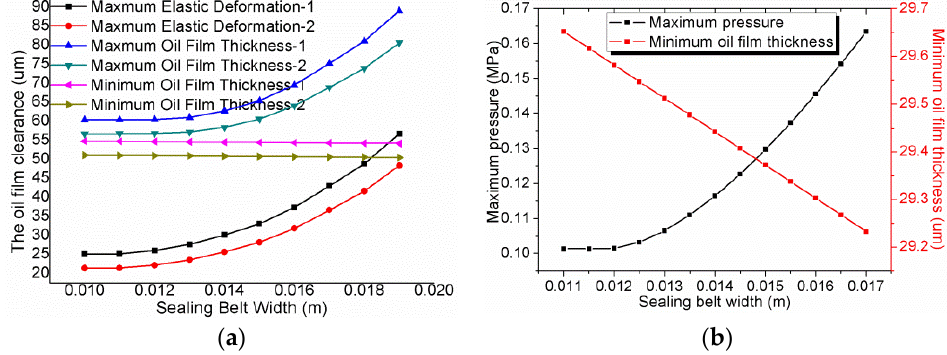
Figure 17. Effect of the sealing belt width on the oil film clearance and pressure. ( a ) the oil film thickness and the elastic deformation with the sealing belt width; ( b ) the minimum oil film thickness and maximum pressure with the sealing belt width.